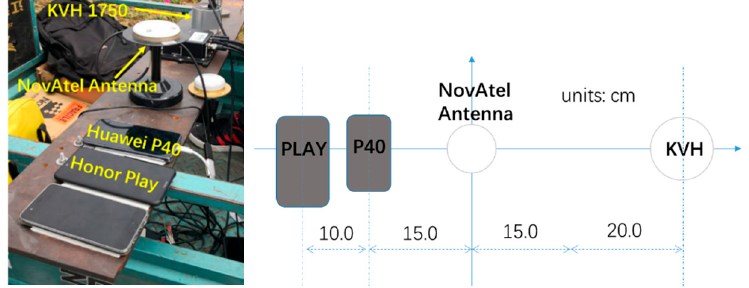
Figure 3. The physical setup of the devices used in the terrestrial test.